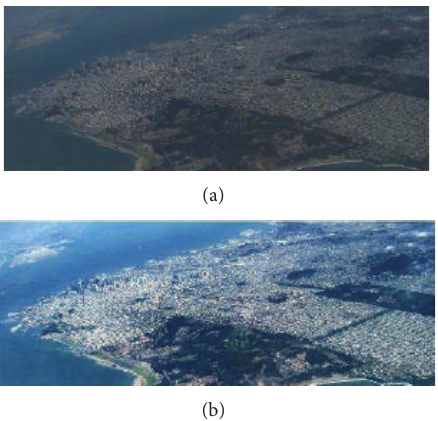
Figure 8: Intensity contrast example. (a) shows a low contrast image whereas (b) shows the same image with high intensity